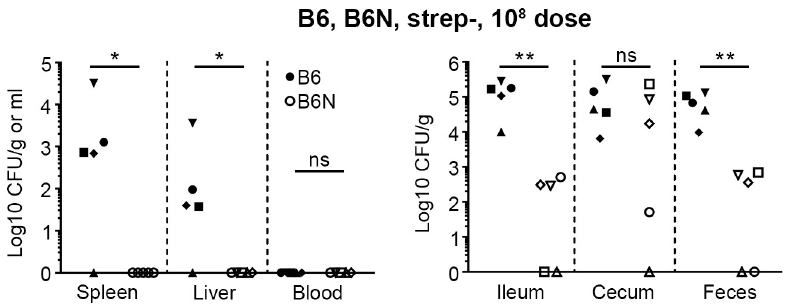
Fig 4. Infection of strep- mice. Bacterial numbers in tissues 3 days p.i. in strep- B6 and B6N mice infected with 10 8 CFU Salmonella . n = 5 mice. Filled symbols represent individual B6 mice and open symbols represent individual B6N mice. Tissues where bacterial load was below the level of detection are given a value of “1” for visualization purposes. Asterix indicates statistical significance; � p < 0.05, �� p < 0.01, ns, not statistically different, two-tailed Mann-Whitney U